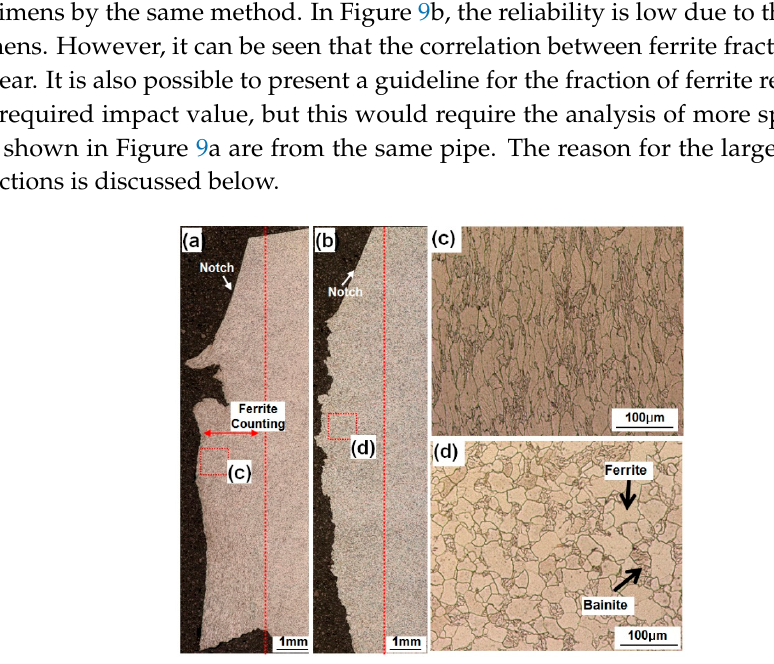
Figure 9. Relationship between volume fraction of ferrite and impact value ( a ) Volume fraction of ferrite for 386J and 28J specimens and ( b ) liner analysis of impact value and fraction of ferrite.